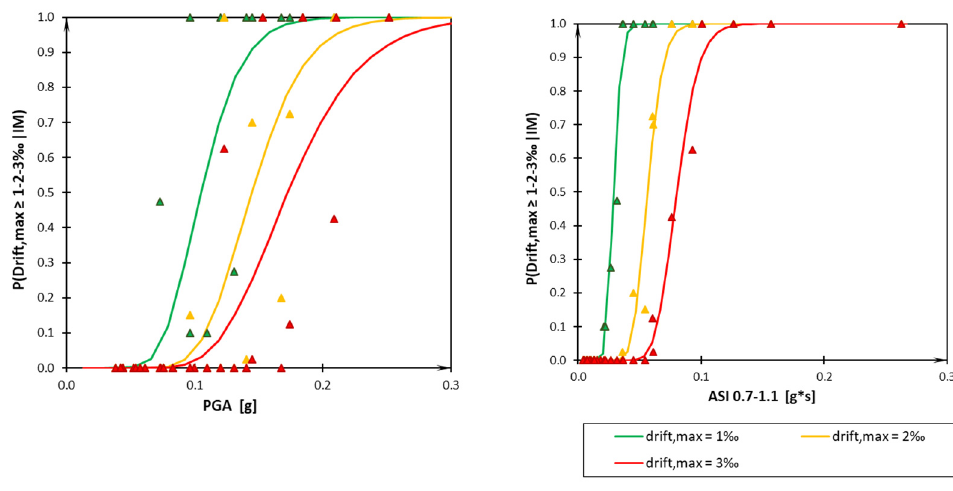
Figure 10. Fragility curves PGA and ASI of the SMAV model.